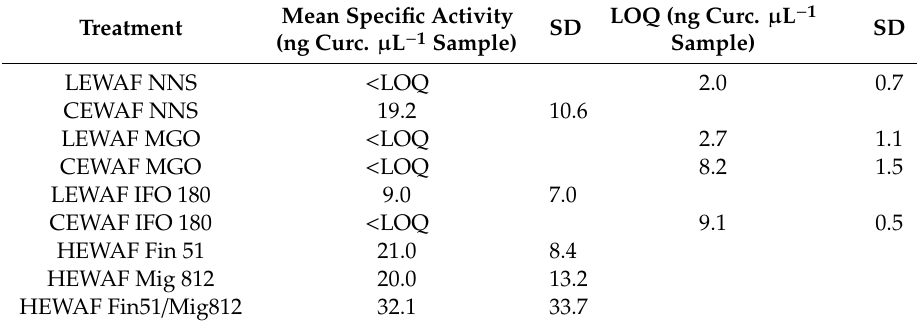
Figure 2. Induction of oxidative stress after exposure to WAF dilutions of petroleum products, dispersant, and inert oil in the Nrf2-CALUX ® assay. Approaches include crude (NNS) and refined petroleum products (MGO, IFO 180), the dispersant Finasol OSR 51 (Fin51), and the inert oil Miglyol (Mig812). Based on luminescence data, the induction factors (IFs) were calculated as relative values to the background of the Curcumin calibration series. Symbols and error bars represent the mean IF of 3–4 independent experiments with standard deviation. HEWAFs were prepared using corresponding amounts to CEWAF approaches. A non-linear regression model with variable slope was used to fit the concentration–response curves in Prism 6 (GraphPad v 6). Table 2. Calculated specific activity of crude oil (NNS) and refined petroleum product (MGO, IFO 180) WAFs in the Nrf2-CALUX ® assay for oxidative stress. Specific activity was calculated based on sample and curcumin (reference) concentrations, resulting in an induction factor (IF) of 1.5 corrected for the reference background and fitted with non-linear regression in Prism 6 (GraphPad. In the case when the specific activity was below the limit of quantification (LOQ), the mean LOQ was added in an additional column ( n =